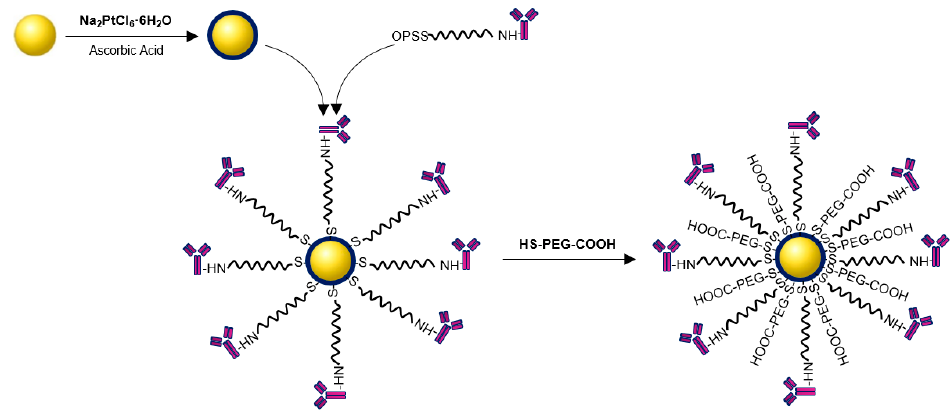
Figure 5. Schematic diagram of the synthesis of Au@Pt-PEG-trastuzumab bioconjugate.